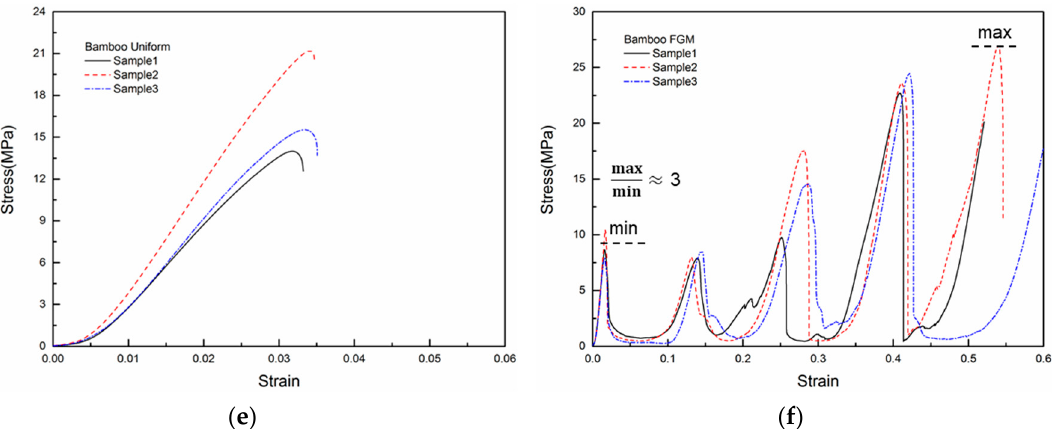
Figure 5. Compressive stress–strain curves of lattice structures: ( a ) cubic uniform ( b ) cubic FGM ( c ) honeycomb uniform ( d ) honeycomb FGM ( e ) bamboo uniform and ( f ) bamboo FGM.